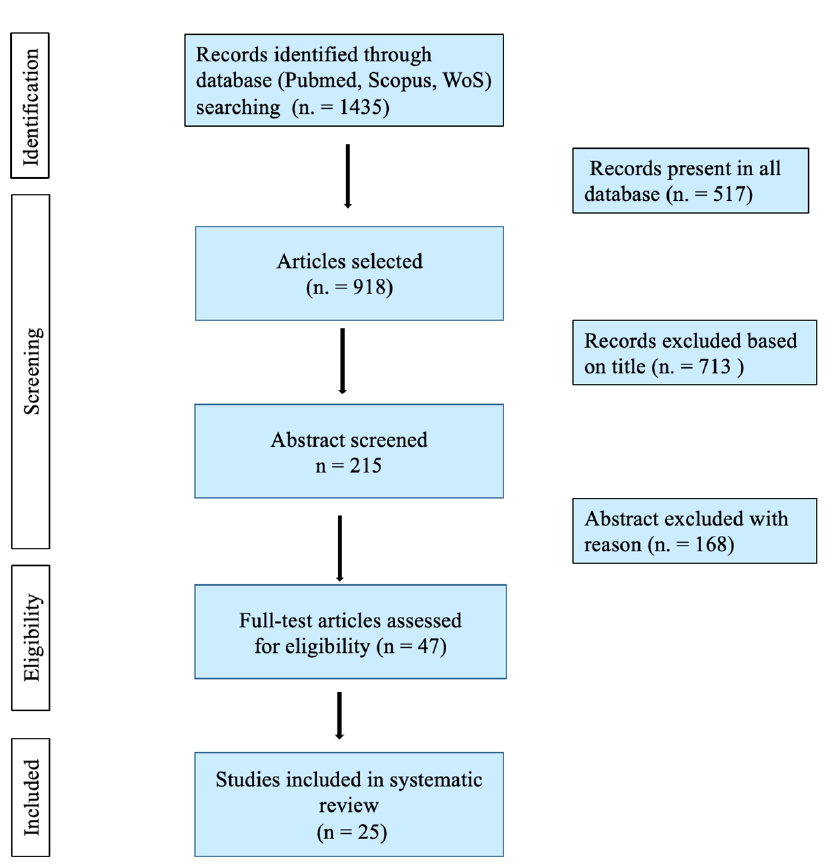
Figure 1. Flowchart of the article selection process. Table 1. Articles included in the revision; first author, reference, title, publication year and article type were schematically reported.